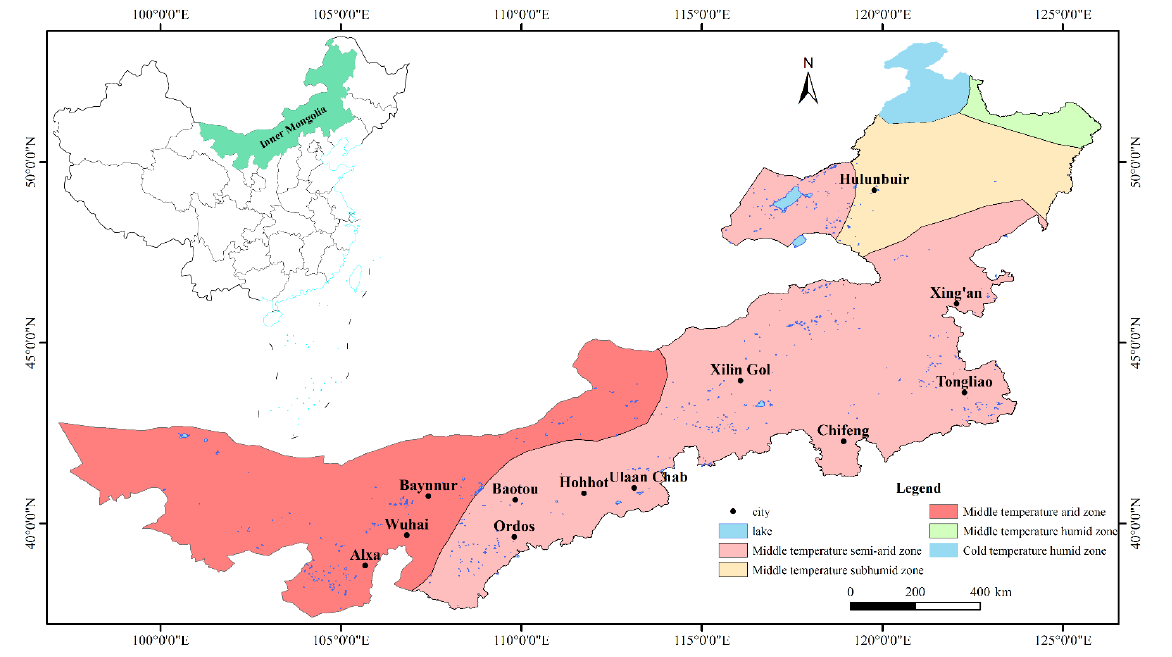
Figure 2. Distribution of lakes in the different climatic zones in Inner Mongolia. Table 5. Number and area of lakes in the different climatic zones.